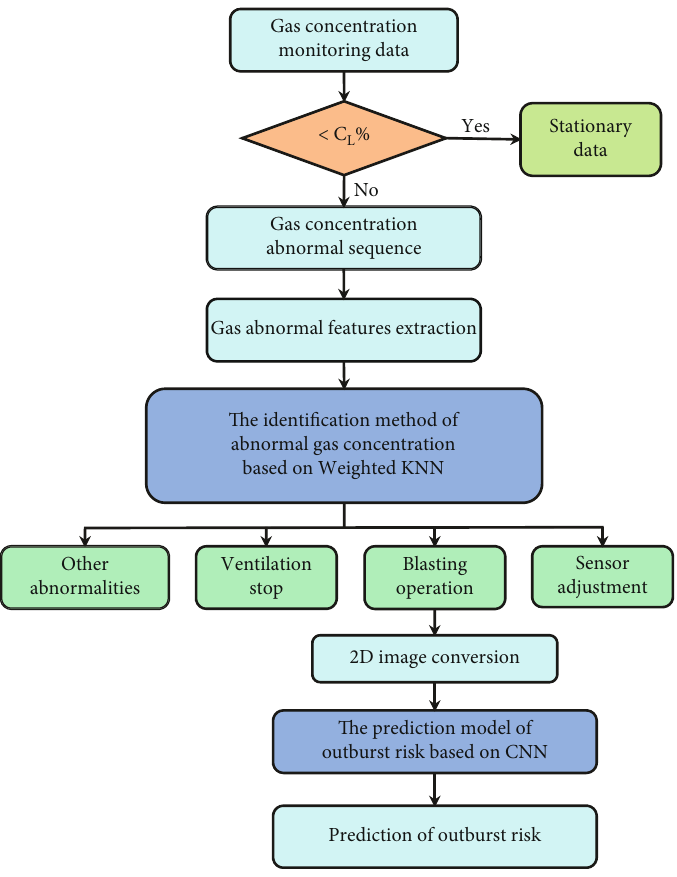
Figure 4: The process of gas abnormal identi fi cation and outburst risk